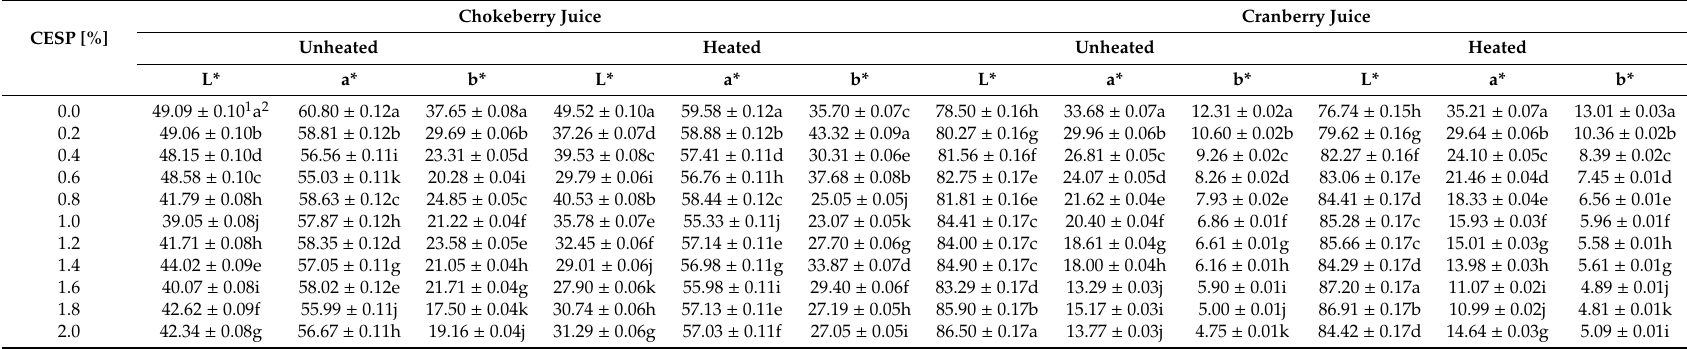
Table 1. The change of CIE L*, a*, b* parameters in the products before and after thermal treatment. CESP: chicken eggshell